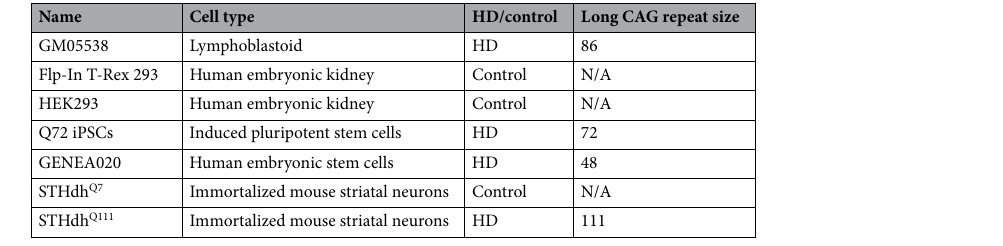
Table 2. Cell lines used in this